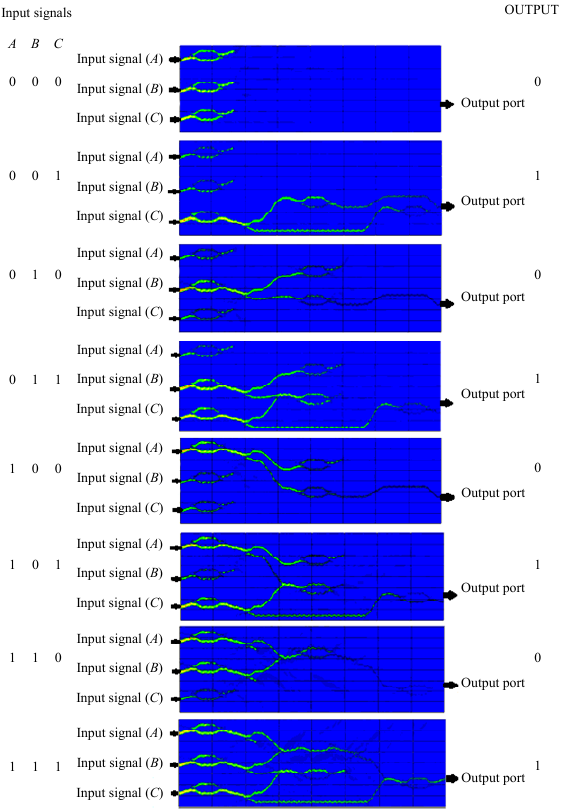
Fig. 9 Propagation of the optical signals through the even parity generator circuit for all possible combinations of input signals obtained through the FDTD